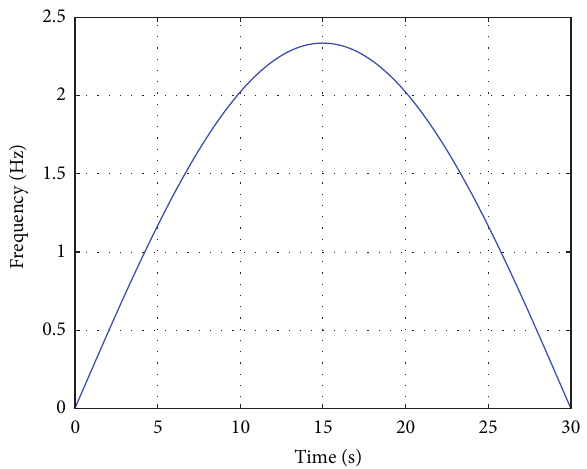
Figure 10: The Doppler frequency difference between Path I and Path II in the flat earth model.